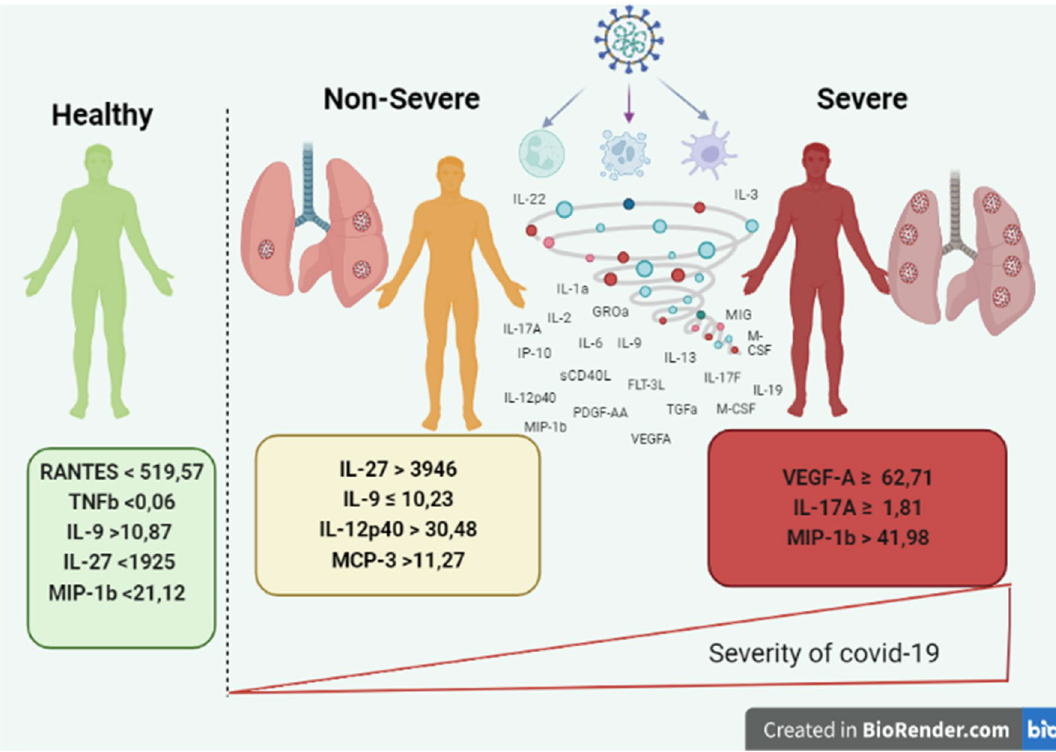
Figure 15. Different Cytokine Profiles Associated with the Progression of COVID-19